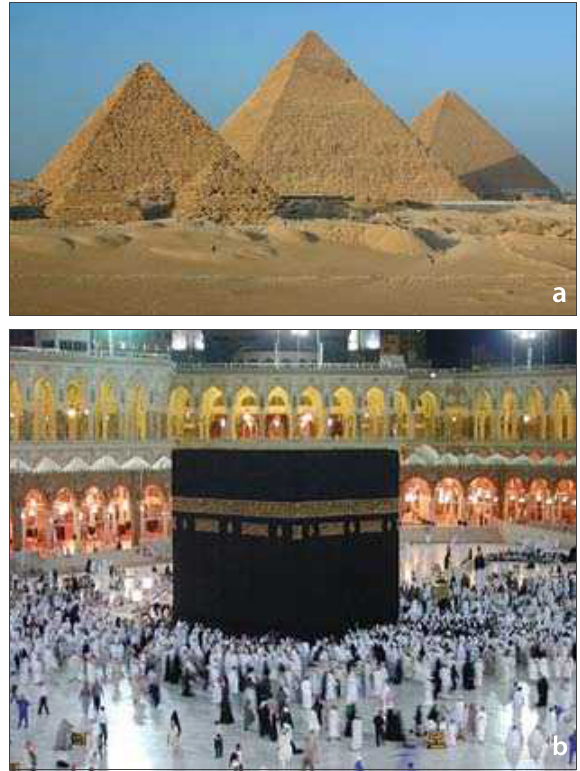
Fig. 1. egypt Pyramids (a); kaaba; Mecca, Saudi